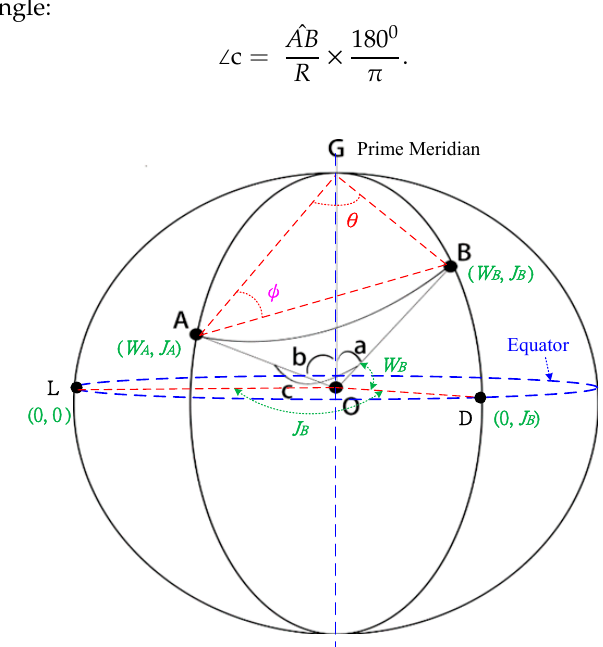
Figure 7. Schematic diagram of the longitude and latitude sphere coordinate algorithm for the drone .